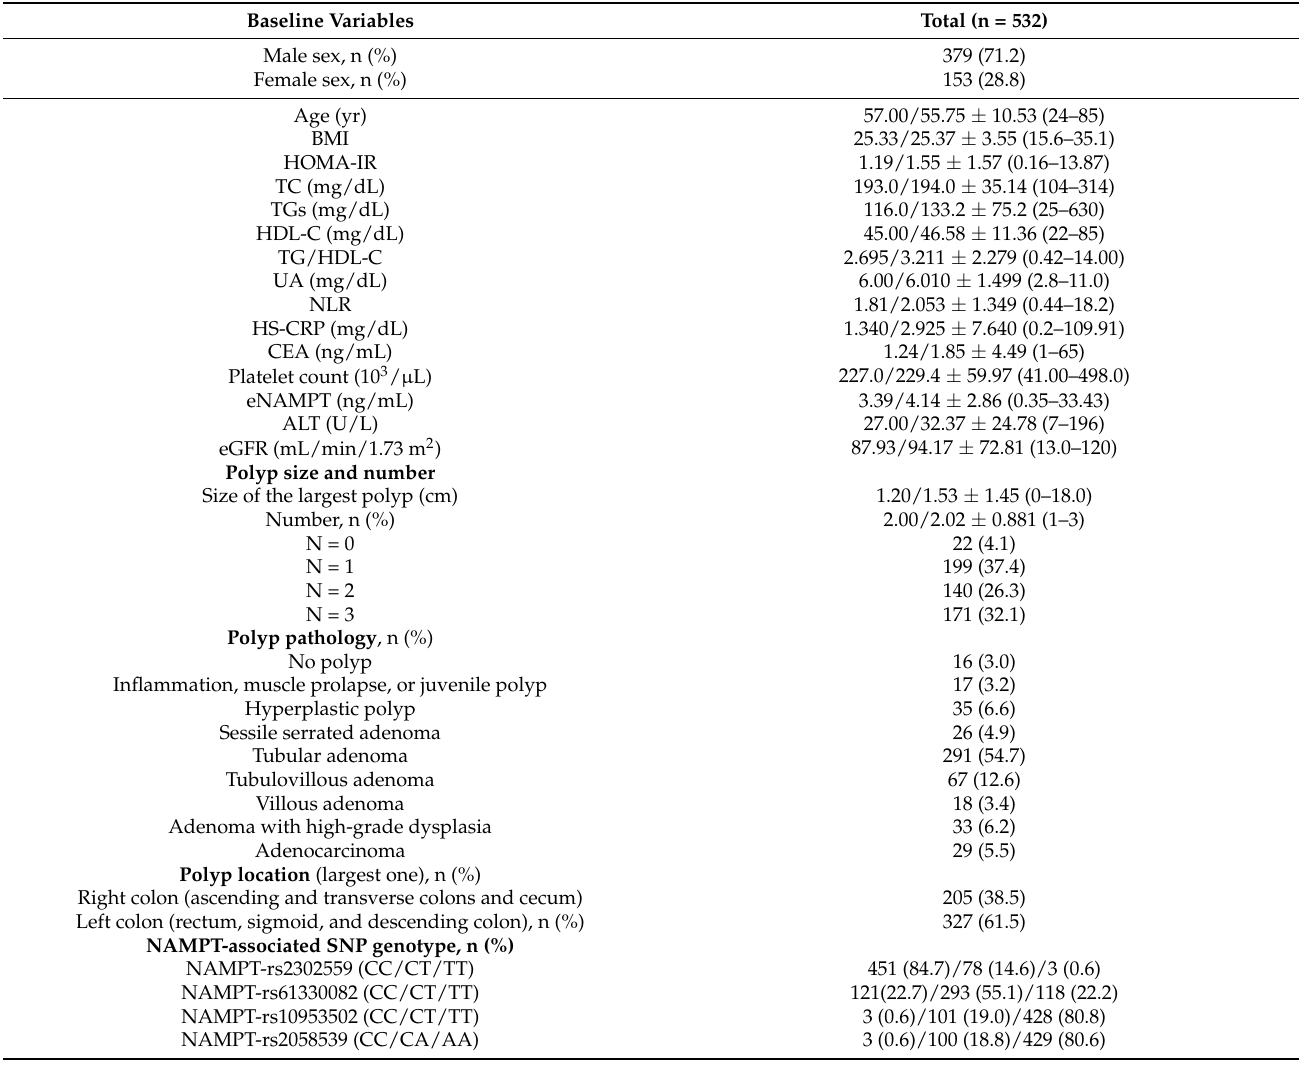
Table 1. Baseline characteristics of patients who underwent colonoscopy (median/mean ± standard deviation